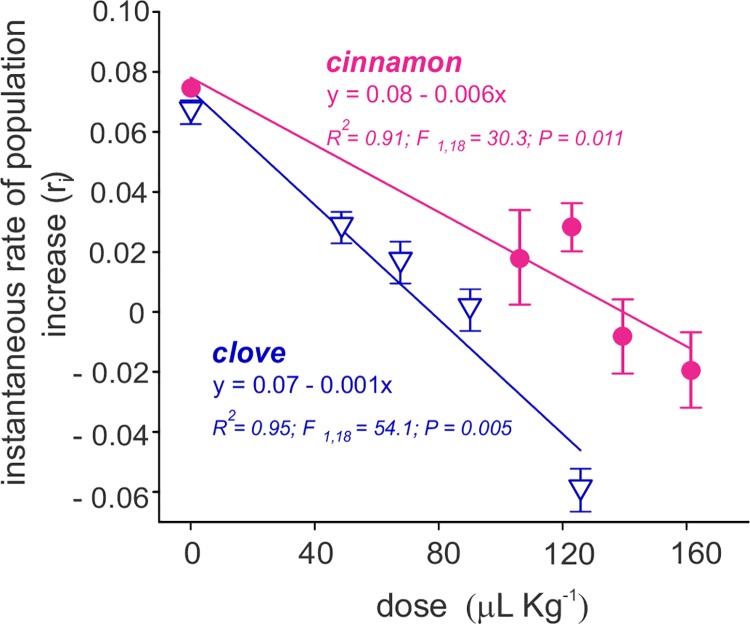
Instantaneous rate of population increase of C. maculatus exposed to clove and cinnamon essential oils.The symbols represent the means of five replicates of the LD0 (control), LD20, LD40, LD60 and LD80 for each oil. The doses are expressed in μL of essential oil/kg beans. The vertical bars represent the SD.